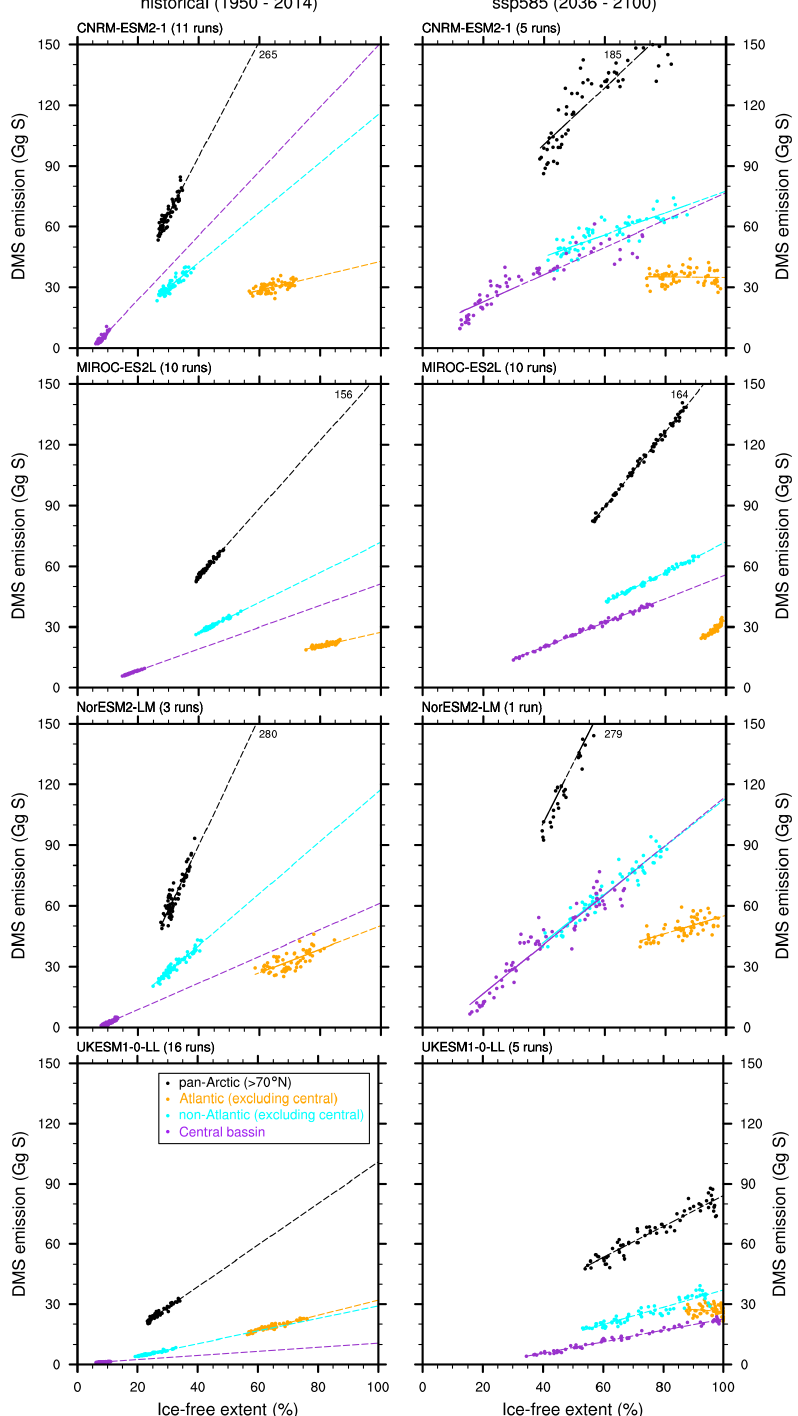
Figure 15. Scatter plots with mean annual May to August values of DMS emissions (Gg S) vs. ice-free extent (%) over the same regions as those of Galí et al. (2019): pan Arctic (black dots), non-Atlantic sector without the central basin (cyan dots), Atlantic sector without the central basin (orange dots), and central basin (purple dots), for the four CMIP6 models (4 rows). Left column: 1950–2014 years, right column: 2036–2100 years. DMS emissions at 100% ice-free extent are indicated for better clarity when the extrapolated values exceed the y axis maximum. The related metrics of these scatter plots are displayed in Table